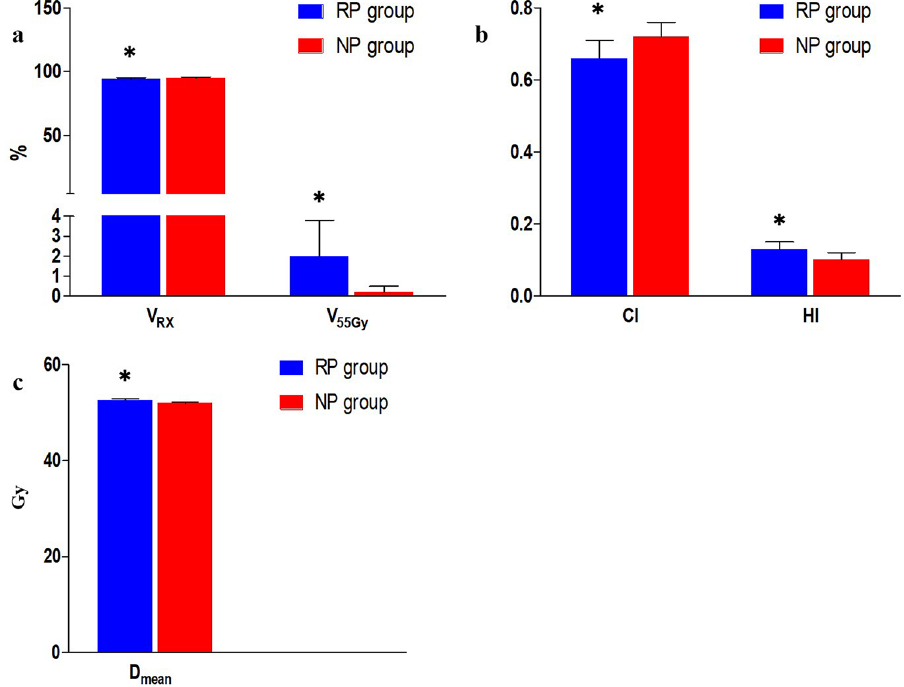
Figure 1. Dosimetry comparison for the PTV of RP group and NP group. VRX of the NP group was higher than that of the RP group (t = − 4.57, P < 0.01) ( a ). CI and HI of NP group was higher than that of RP group